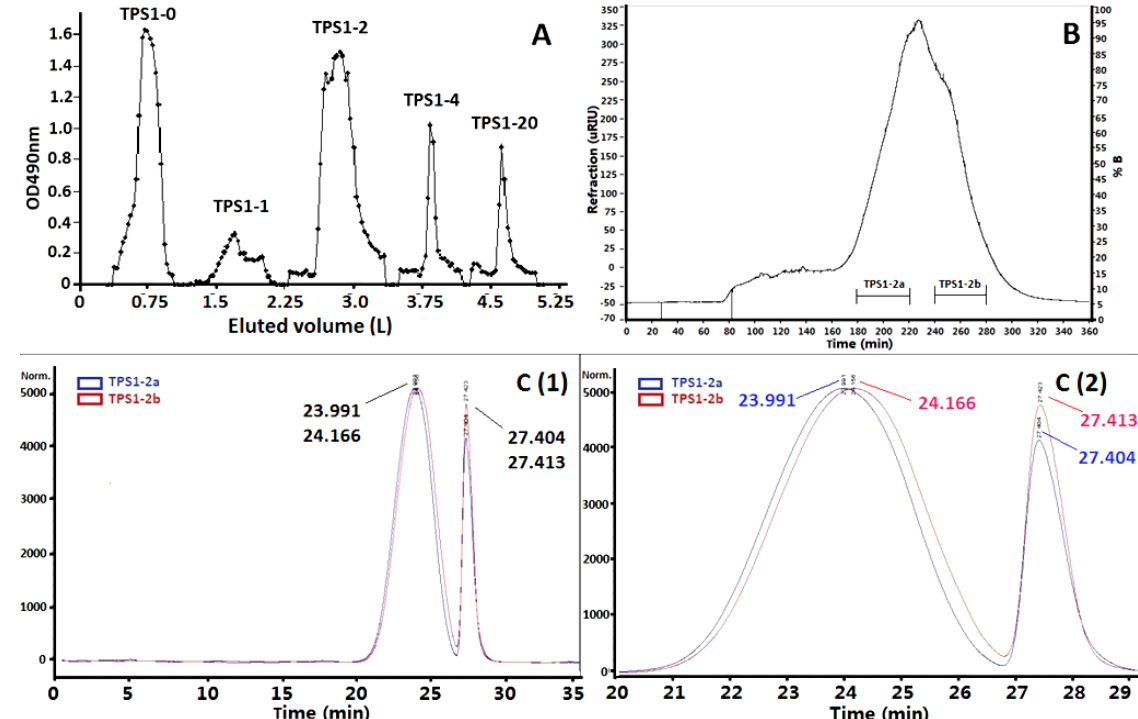
Figure 3. ( A ) Profile of TPS1 in DEAE-cellulose column (Tube volume: 15 mL); ( B ) TPS1-2 in High-Resolution Sephacryl™ S-300 (TPS1-2a: 180–220 min and TPS1-2b: 240–280 min), and TPS1-2a and TPS1-2b in HPGPC ( C ( 1 ), 0–35 min; C ( 2 ), 20–29 min, a small gap at Y -axis of NaCl peaks as the eluants of slightly different NaCl concentration were used to